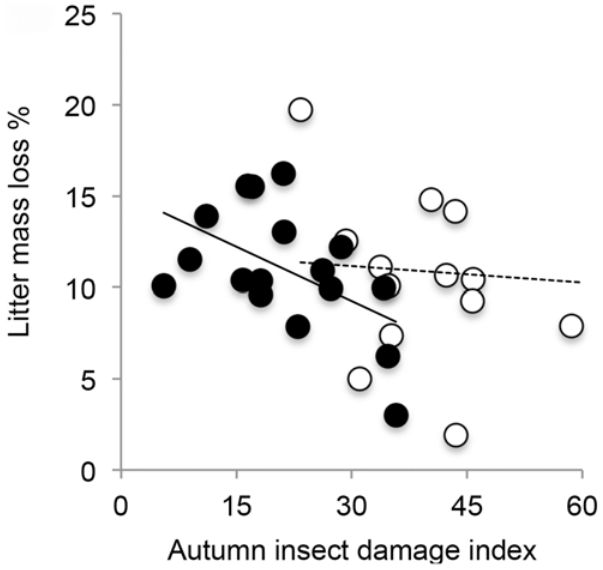
Figure 3. Correlation of genotype means of autumn insect damage index and litter mass loss for control (white dots) and treated (black dots) seedlings.